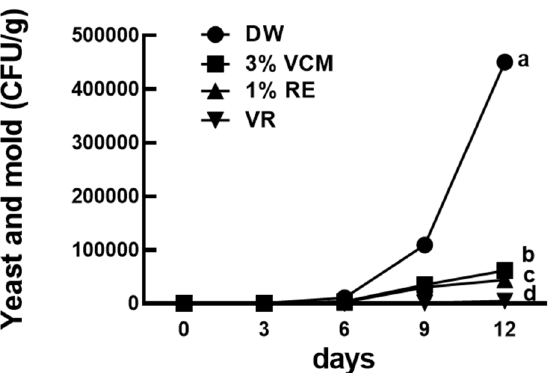
Figure 5. Changes in the counts of yeast and mold (CFU/g) in freshly cut apples during storage at 4 °C. The freshly cut apples are coated with DW, VCM 3%, RE, and VR. One-way ANOVA determined statistical significance (mean ± SE, n =